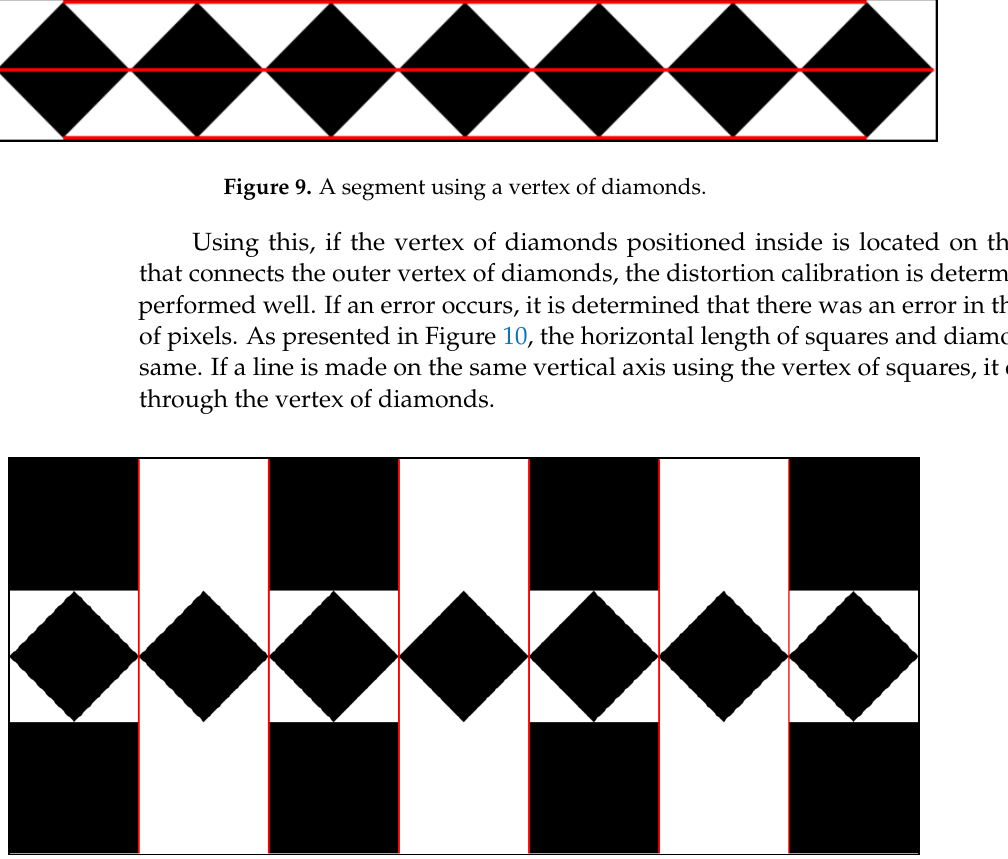
Figure 11. Two rectified images, epipolar line, and diamond segments.